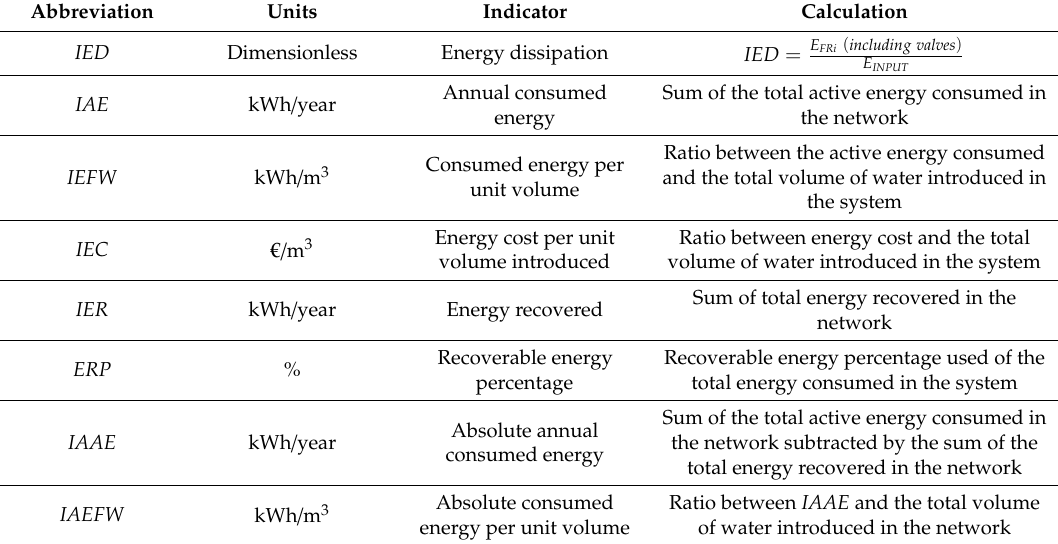
Table 6. Proposed sustainability